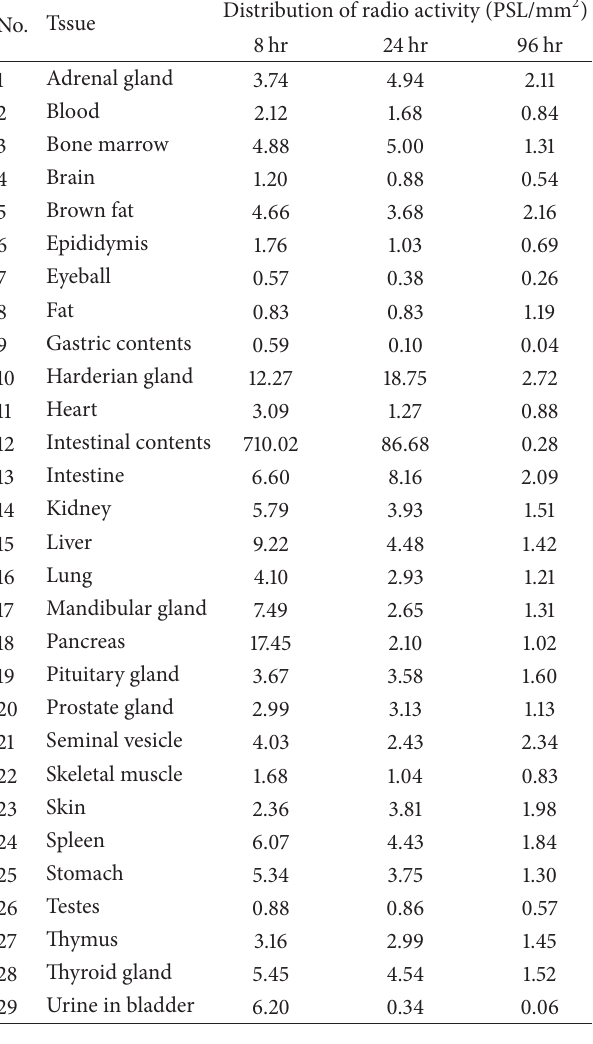
Table 3: The distribution of radioactivity in selected organs and tissues as [ (photostimulated luminescence-background)/area ] after single oral administration of 14 C hyaluronic acid to rats at a dose of 25 mg/kg.